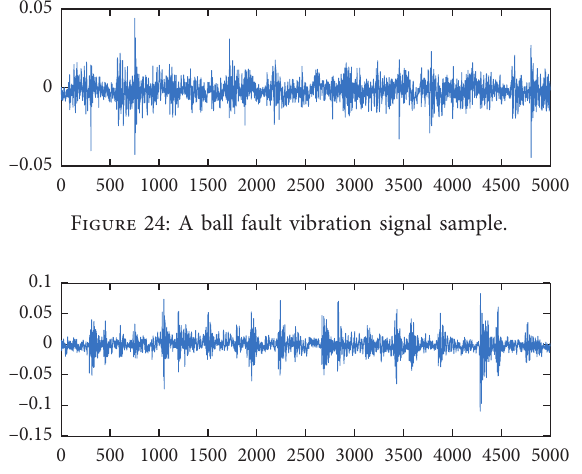
Figure 25: An inner race fault signal sample.